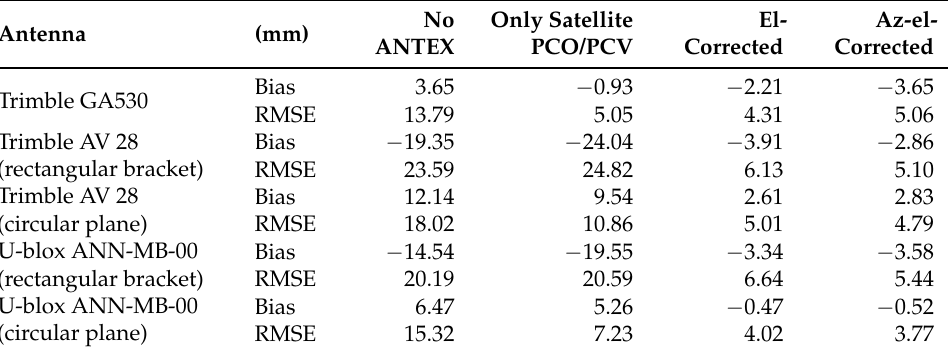
Table 6. ZTD estimation based on antenna corrections with no ANTEX corrections, only satellite PCO/PCV corrections, elevation corrected ANTEX and azimuth-elevation corrected ANTEX entries on the antennas Trimble GA530, Trimble AV28 and U-blox ANN-MB-00. Bias and RMSE refer to the